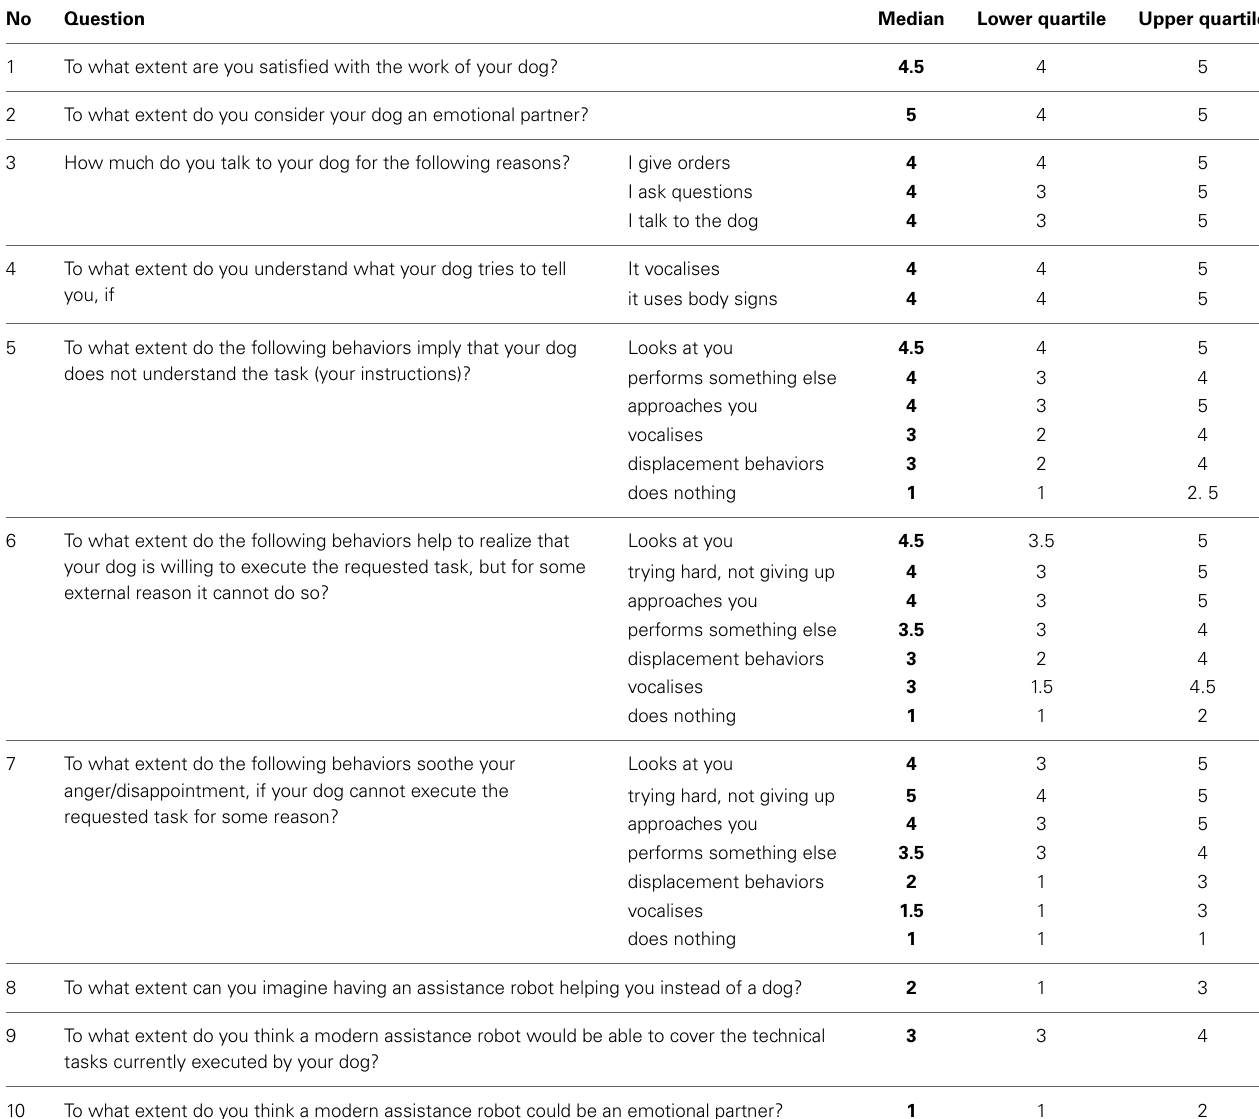
Table 2 | The questions and results in Study 3: The median and quartiles of assistance dog owners’ scores (1-5). No